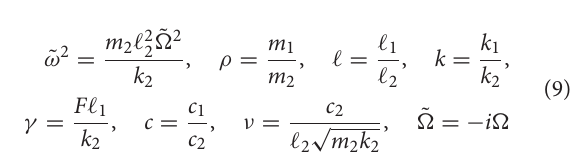
FIGURE 8 | Codimension-one eigenvalues evolution of undamped Ziegler double pendulum under increasing follower load F ( ρ v 0. =